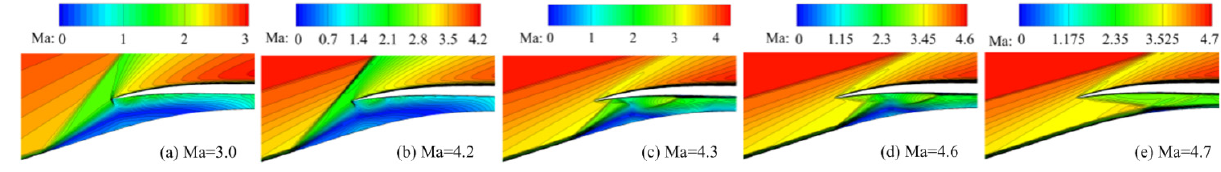
Figure 8. Mach number contours during the second type of starting process ( δ = 10°).